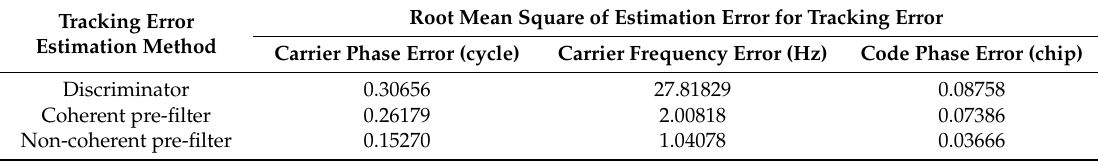
Table 4. Performance comparison of tracking error estimation methods in test scene C.